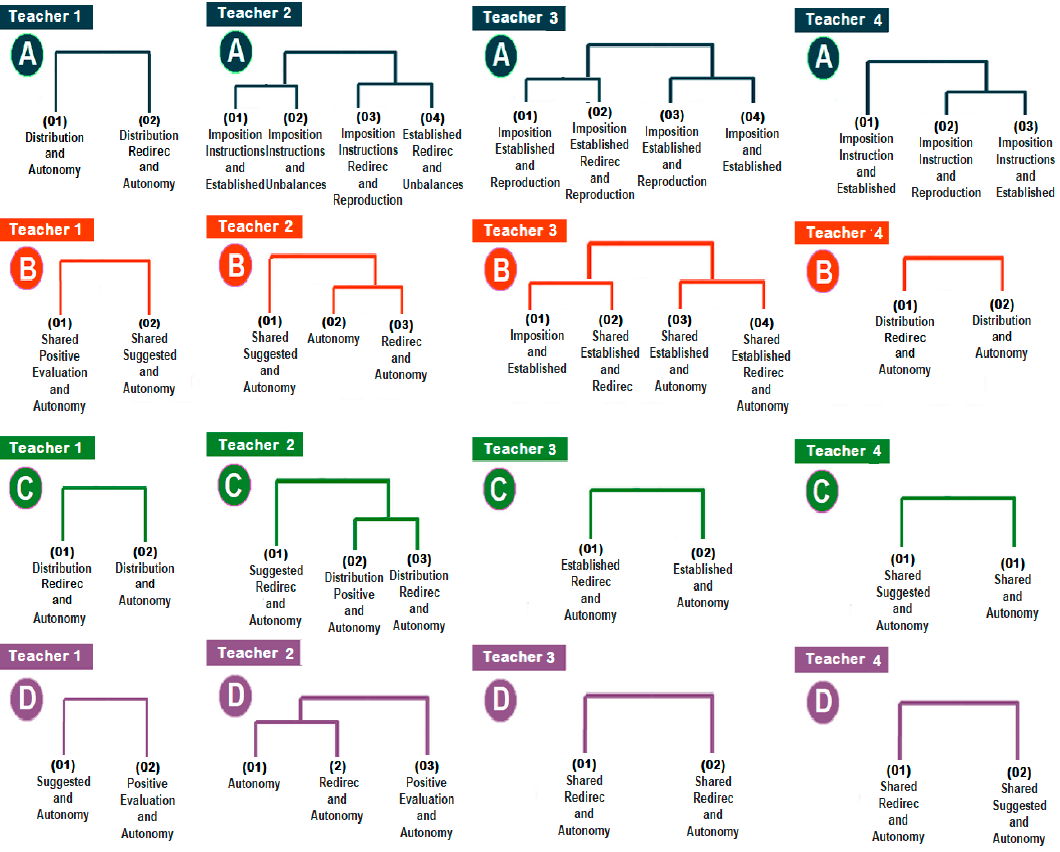
Figure 2. The T-patterns of the four teachers (1, 2, 3 and 4) throughout the four levels (A, B, C and D) of TPSR implementation.